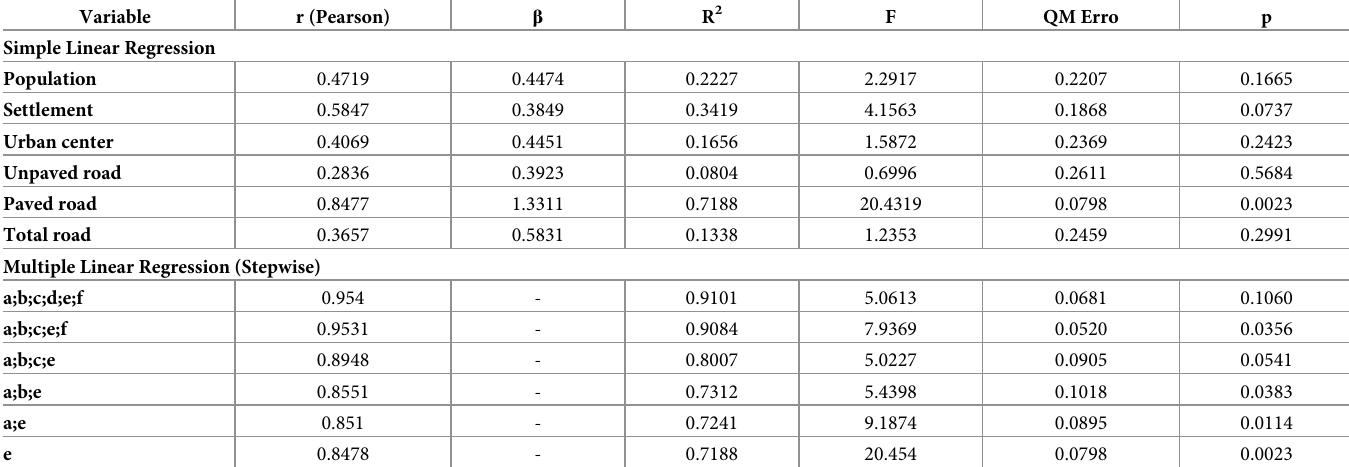
Table 3. Results of the simple linear and multiple (stepwise) regressions between the occurrence of land use in the mangrove and anthropogenic drivers on the Bra- zilian Amazon coast. p = significance level ( α = 0.05); a-Population; b-Settlements; c-Urban centers; d-Unpaved road; e-Paved road; f-Total roads.